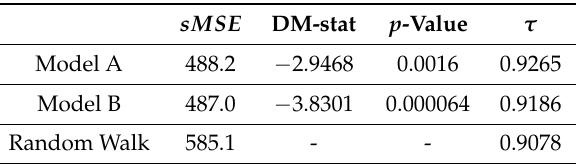
Figure 31. Model B: L p -norm F-transform forecast (denoted as fFor) for the last 1200 days of available data for Bitcoin series (observed time series is denoted as fSer). Here, p = 1.5, q = 1 and two lags l = 4 − fFor t ( top two pictures), l = 5 ( bottom ). The percent errors 100 fSer t are also plotted. fSer t Table 6. Diebold–Mariano test statistics for L p -norm forecasting results The table shows indexes √ sMSE = MSE and Kendall rank correlation τ , corresponding to lag l = 1 forecasts for Models A and B, obtained with p = 1.5, q = 1 and bandwidth r =